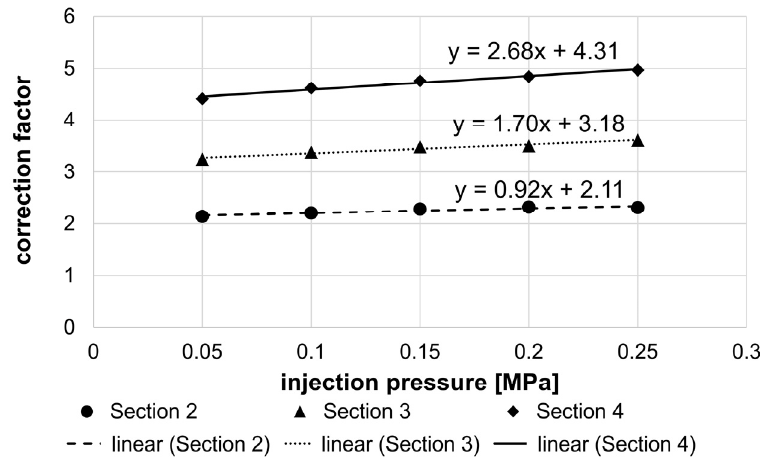
Figure 14. Determined correction factors for the adjustment of the measured length ratios to the calculated time ratios according to Gueroult.